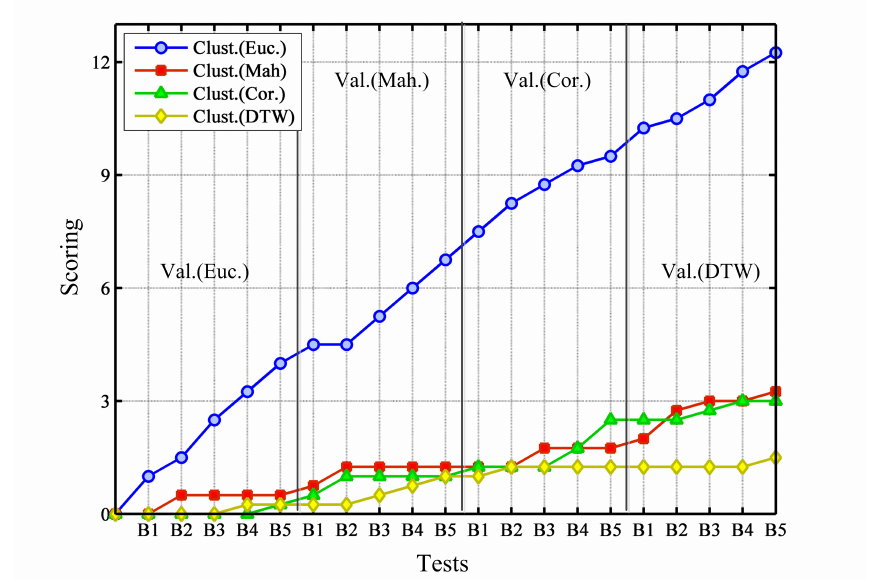
Figure 4. Joined assessment carried out by clustering validity methods.